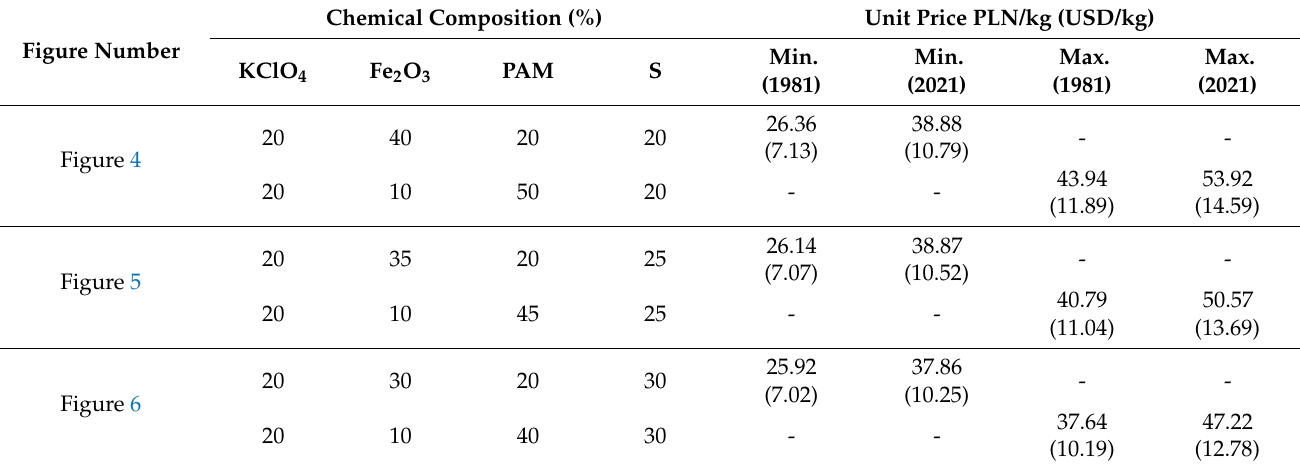
Table 6. A summary of the lowest and highest cost of pyrotechnic compositions from the M-1 group.